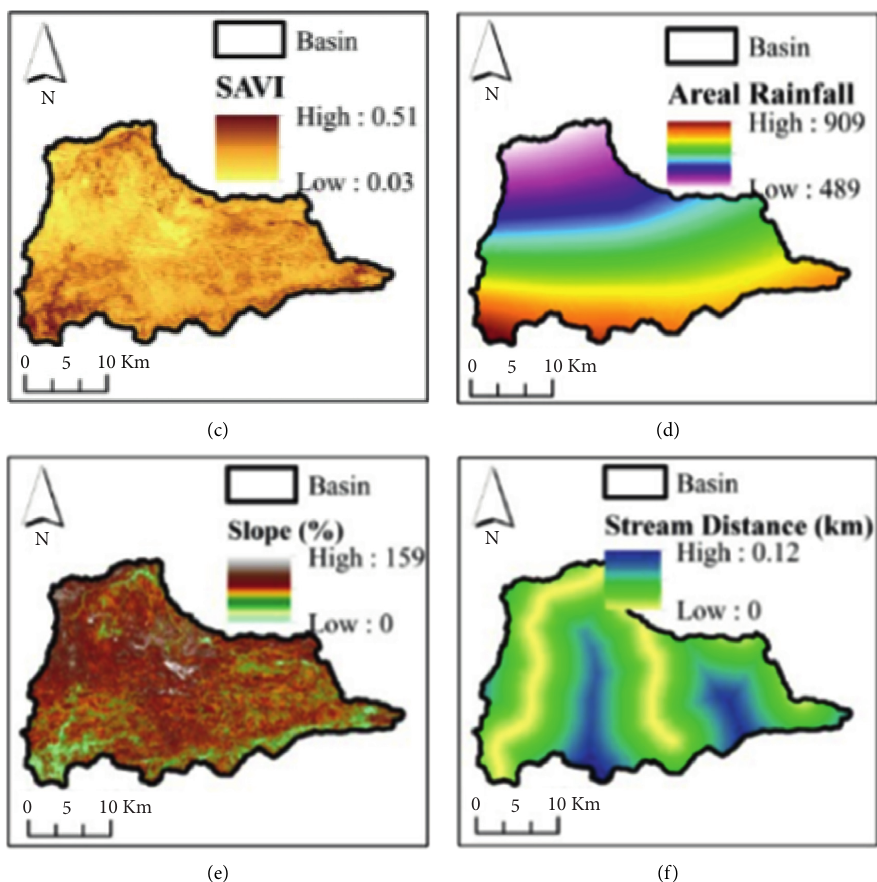
Figure 3: Flood causing factors: (a) R-factor, (b) NDVI, (c) SAVI, (d) areal rainfall, (e) slope, and (f) stream distance from main